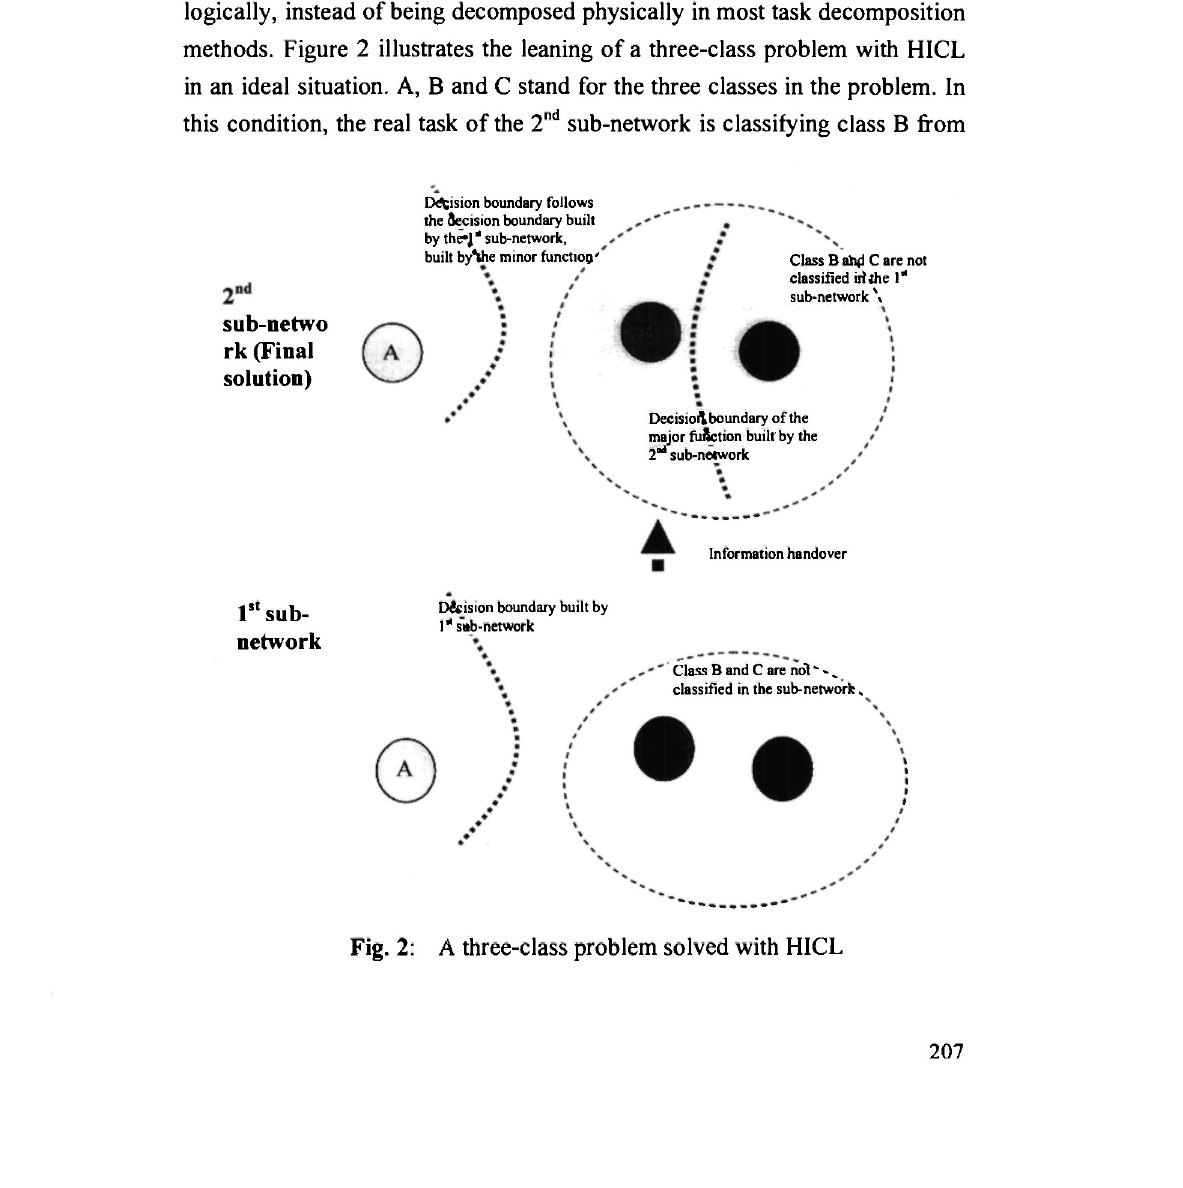
Fig. 2: A three-class problem solved with